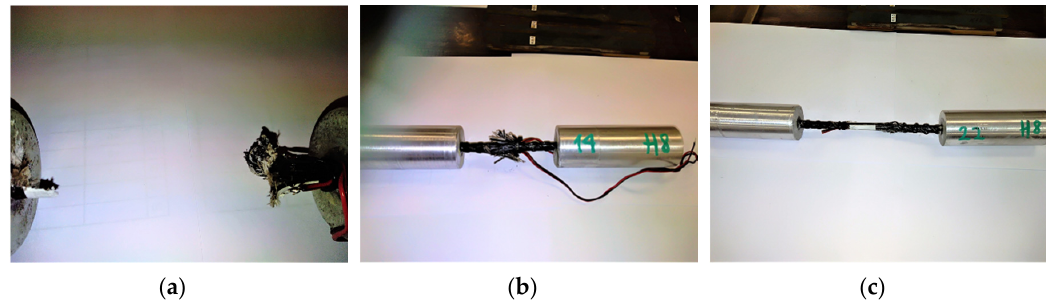
Figure 9. Failure mode of HFRP bars with a diameter of 8 mm: ( a ) Crushing the sample with L f = 6 d b ; ( b ) buckling and crushing of the sample with L f = 14 d b ; ( c ) buckling of the sample with L f = 22 d b .